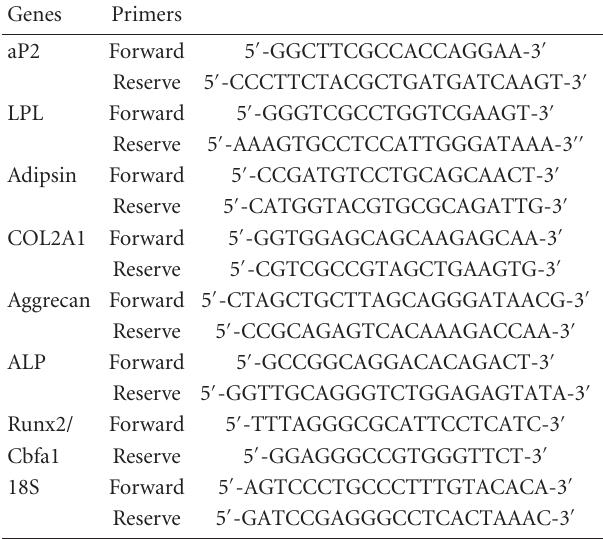
Table 1: Primer sequences used for real-time